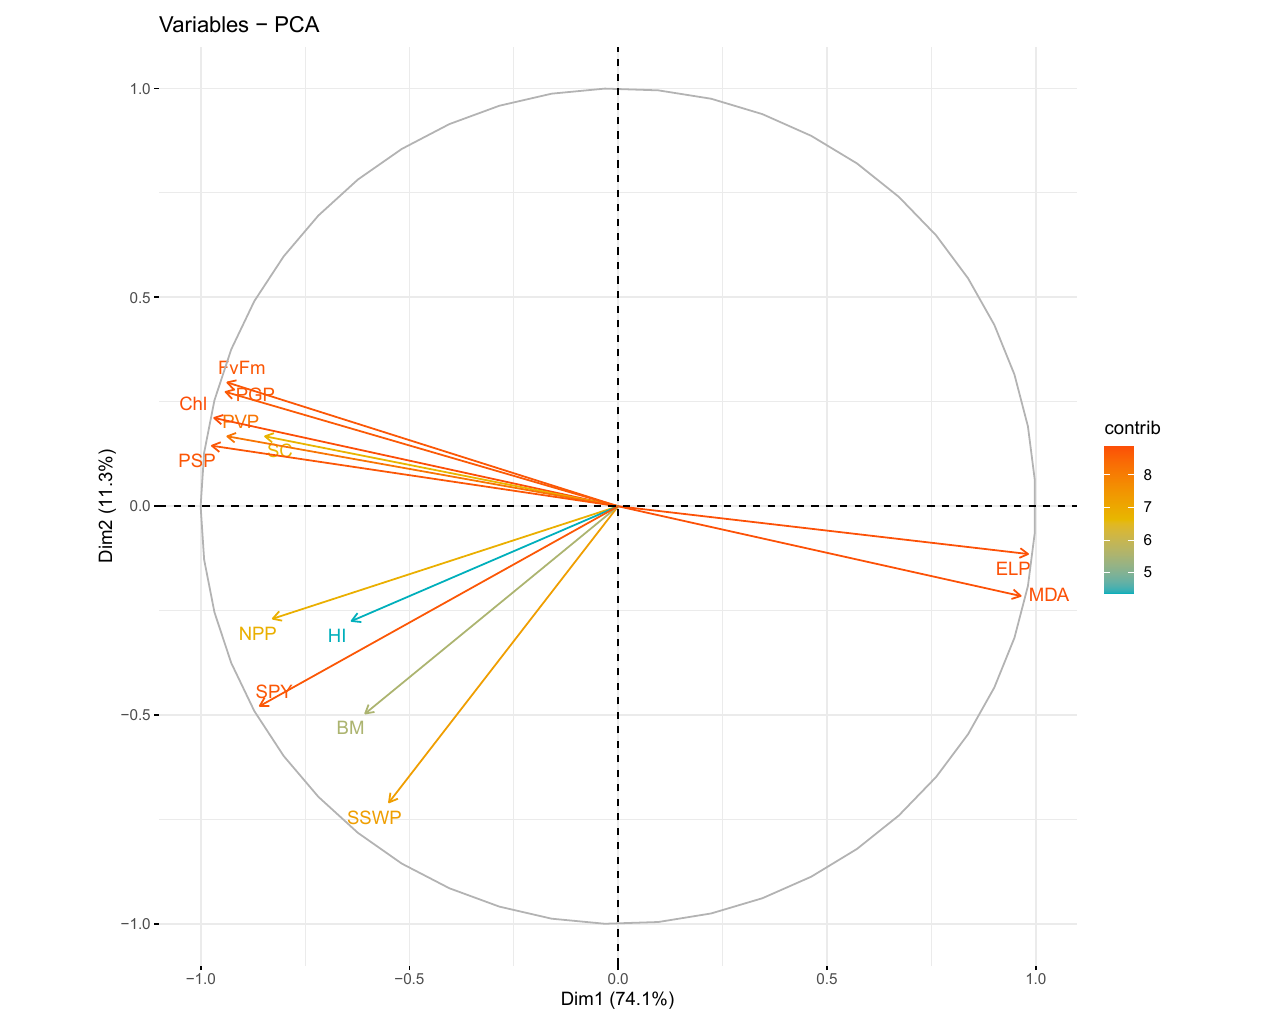
FIGURE 5 | Principal component analysis (PCA) of various traits in chickpea genotypes under heat stress in 2017–2018.